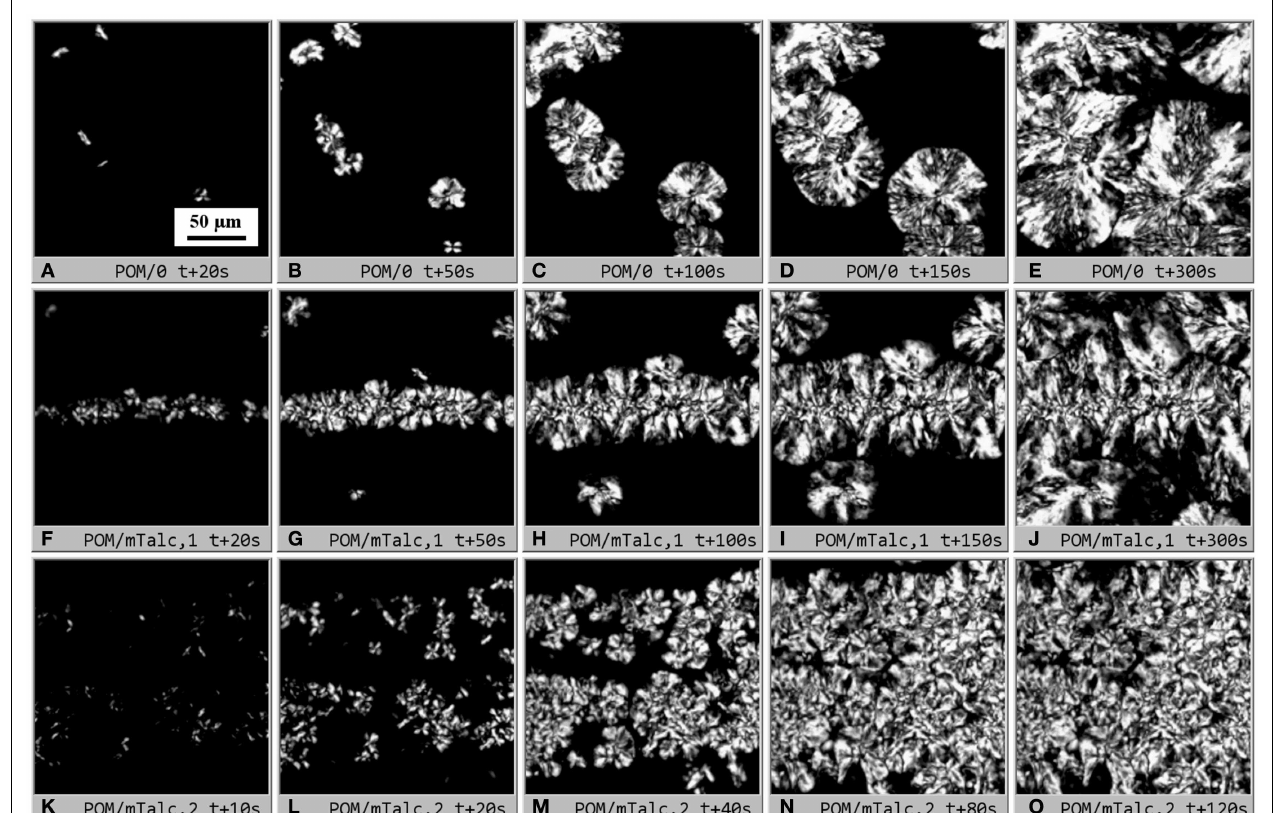
compact nucleant layer and (K–O) thick and diluted nucleant layer (due to sandwich melting).The micrographs (F–J) and (K–O) show two limiting cases – typical nucleant layer thickness in most sandwiches was between these two extremes. Sandwich preparation is described in Sections “Materials,” “Preparation of Sandwich Composites,”and “Isothermal Crystallization in Polarized Light